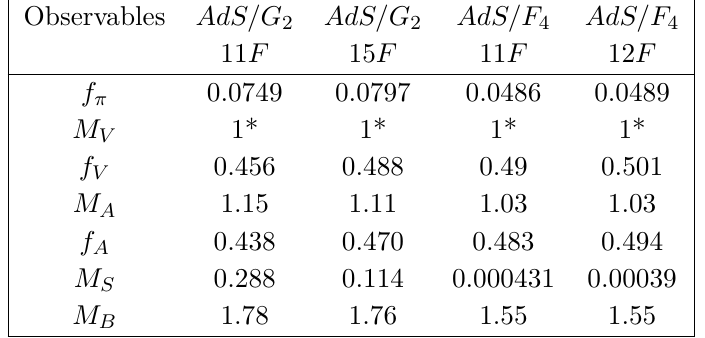
Table 6. Holographic predictions for the spectra and decay constants of AdS/ G 2 , 11 F , AdS/ F 4 , 11 F , and AdS/ F 4 , 16 F